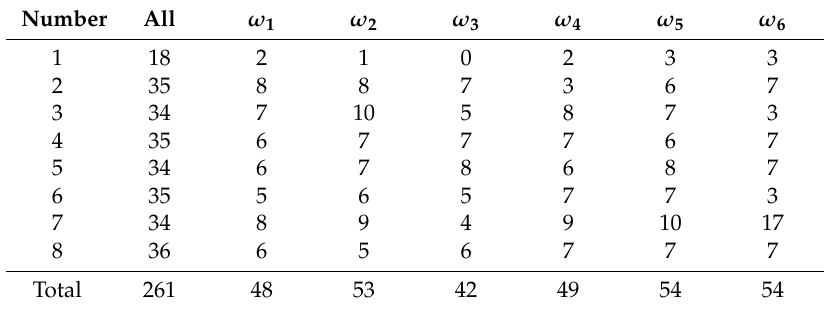
Table 2. The number of main virtual distortions corresponding to the first six frequencies of each substructure.